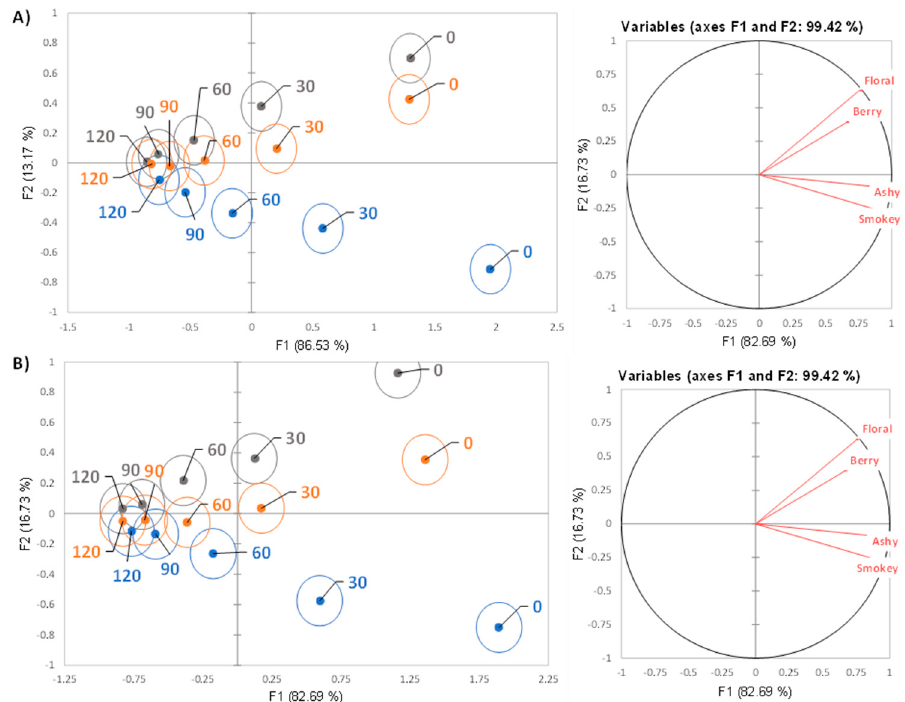
Figure 2. Separation of high-smoke-exposure (blue), moderate-smoke-exposure (orange), and no- smoke-exposure (grey) wines at 30 s intervals, based on DA for the pectin ( A ) and glucose ( B ) rinse systems. Ellipses represent a 95% confidence interval around the means.